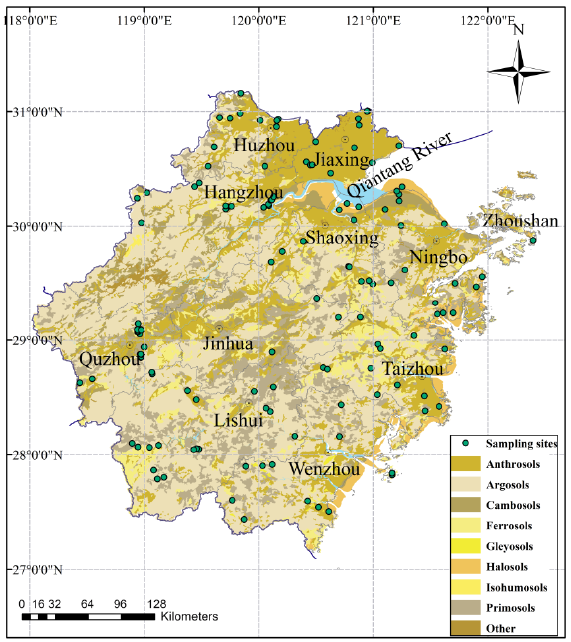
Figure 1. Location of the study area and the sampling sites of soil profiles.